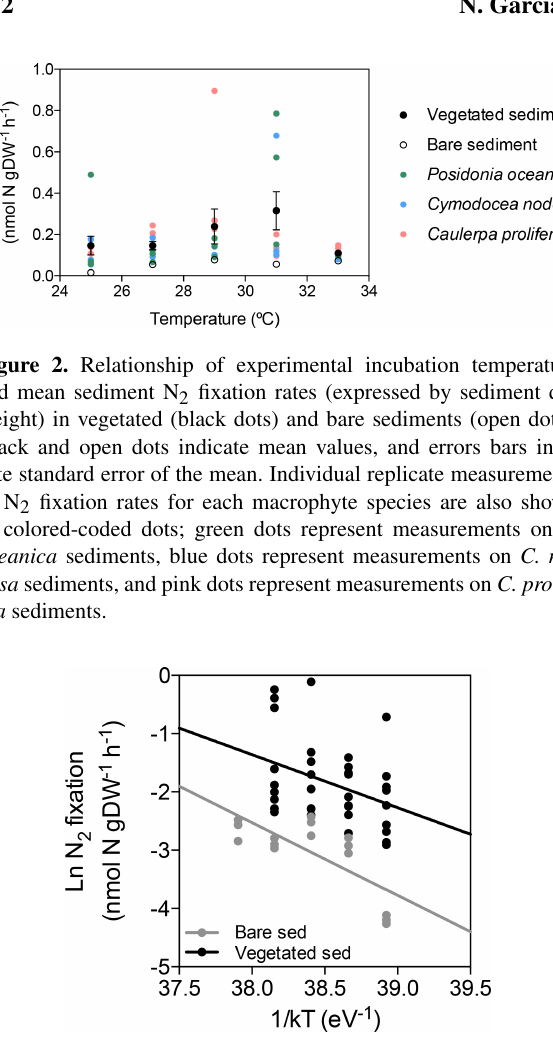
Figure 3. Arrhenius plot for N 2 fixation rates in vegetated (black dots) and bare sediments (grey dots), showing the linear regression between ln N 2 fixation rates and the inverse of the temperature mul- tiplied by the Boltzmann constant (1/kT) for vegetated (black solid line) and bare (grey solid line)